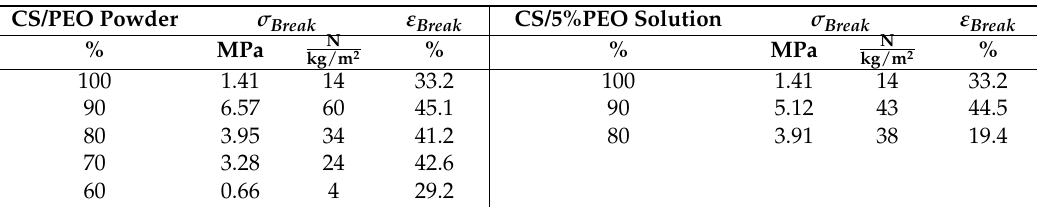
Table 3. Experimental data obtained in uniaxial tensile test on blended films after PEO extraction (PEO 1 × 10 6 ) and drying under wet state.